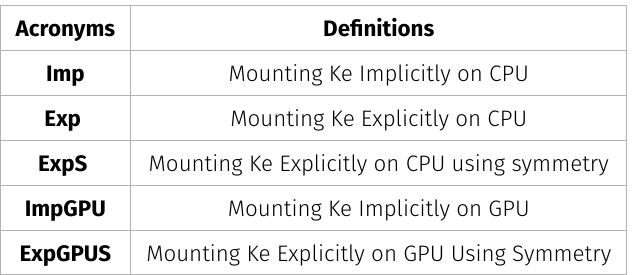
Table III. Some important definitions.